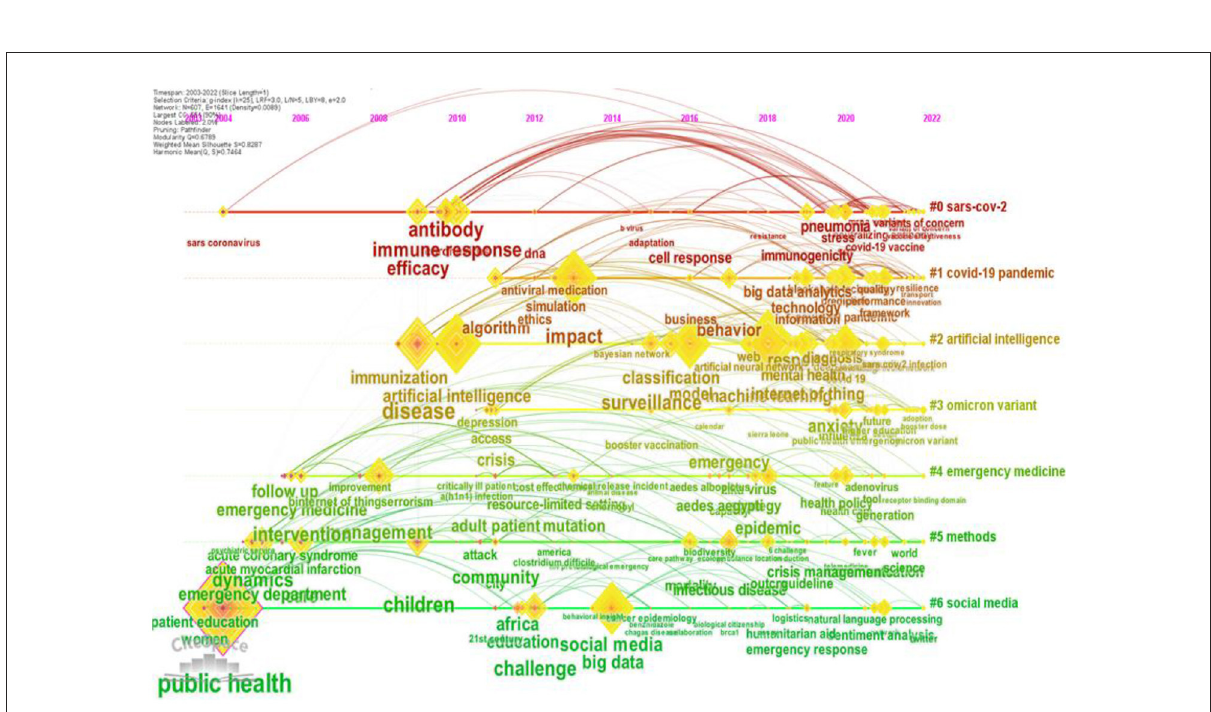
FIGURE8 The keywords view of publications on emergency public health emergency management from 2003 to